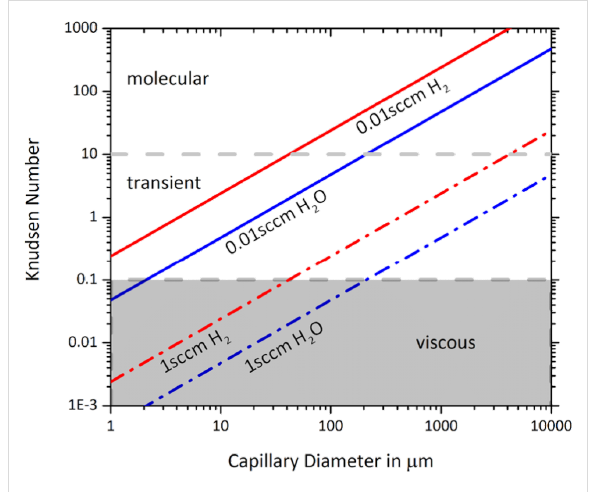
Figure 5: Molecule flow regimes for two flow rates Q of H 2 and H 2 O. Note that 1 sccm = 4.48 × 10 17 molecules/second, using Avogadro’s number and the standard volume of 22.4 L/mol of an ideal gas at 0 °C and 1